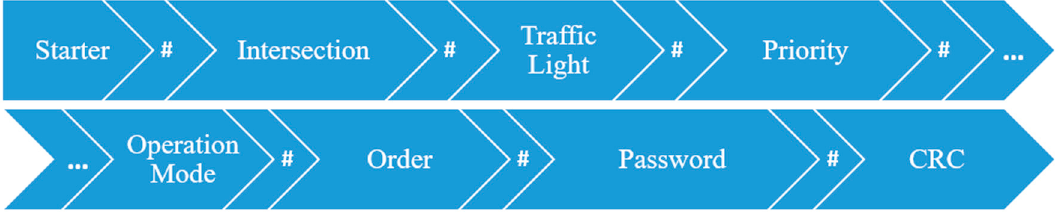
Figure 3. Diagram of the developed communication protocol (CP).